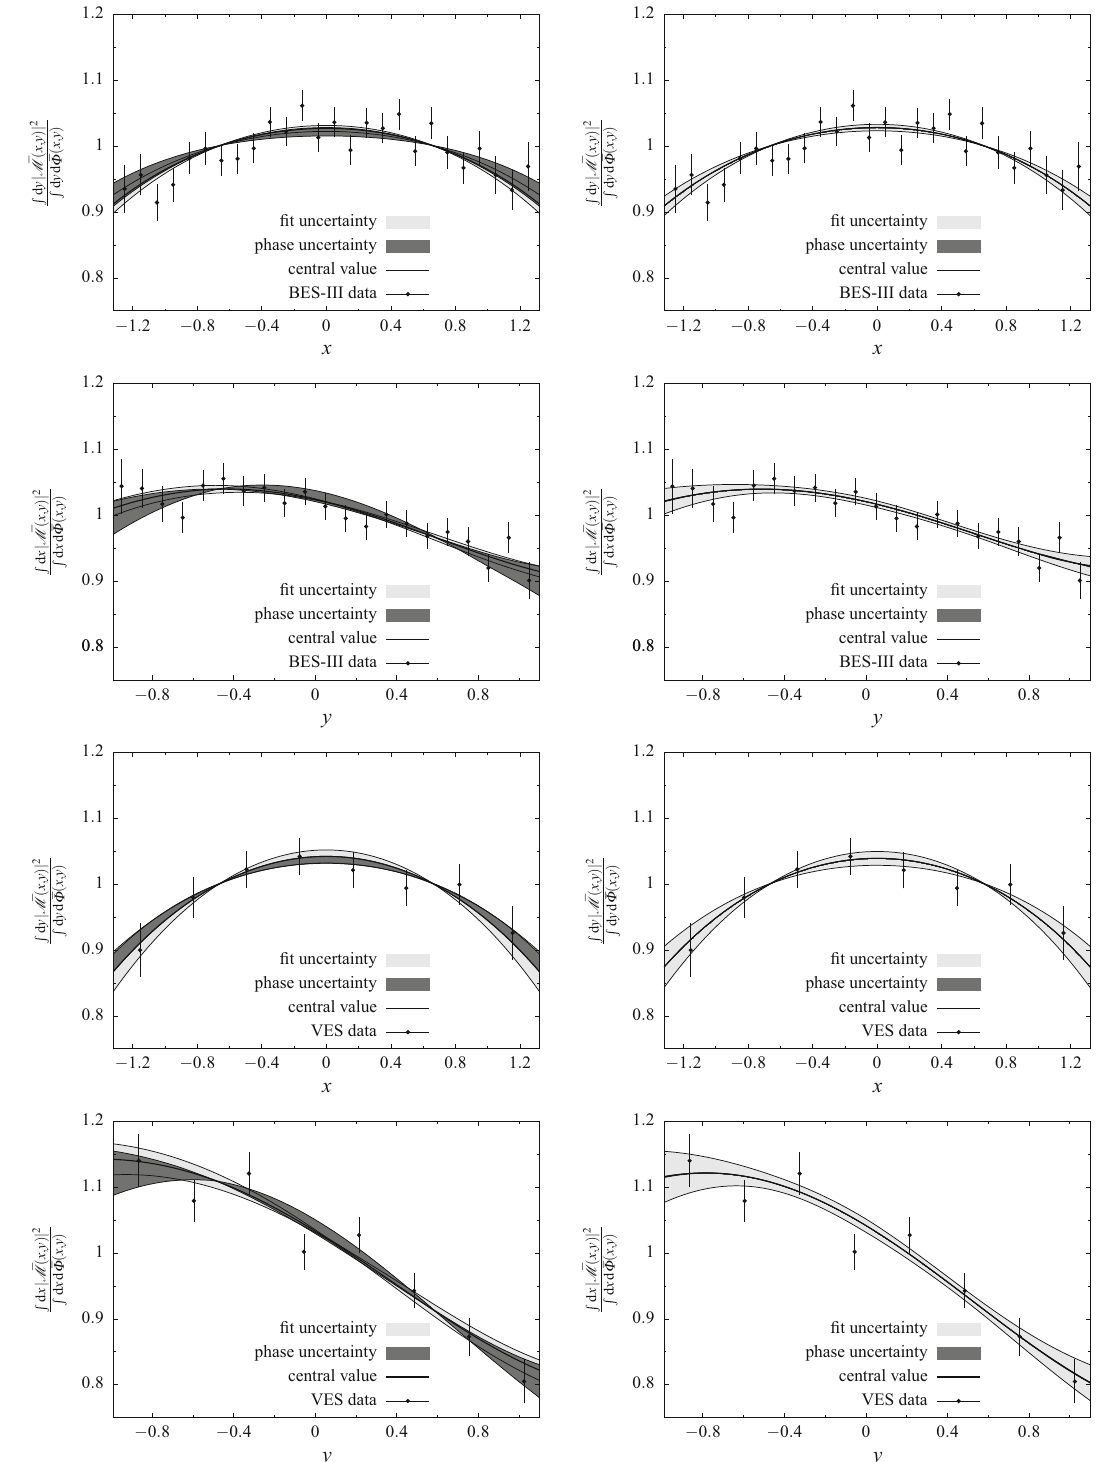
Fig. 7 Decay spectra for η (cid:2) → ηπ + π − integrated over the variable y and divided by the integral over the normalized phase space d ¯ (cid:19)( x , y ) ( first and third rows ), where both are individually normalized as given in Eq. (37). Analogously for x ↔ y ( second and fourth rows ). We show the sampled data sets for the BES-III [25] ( first and second rows )